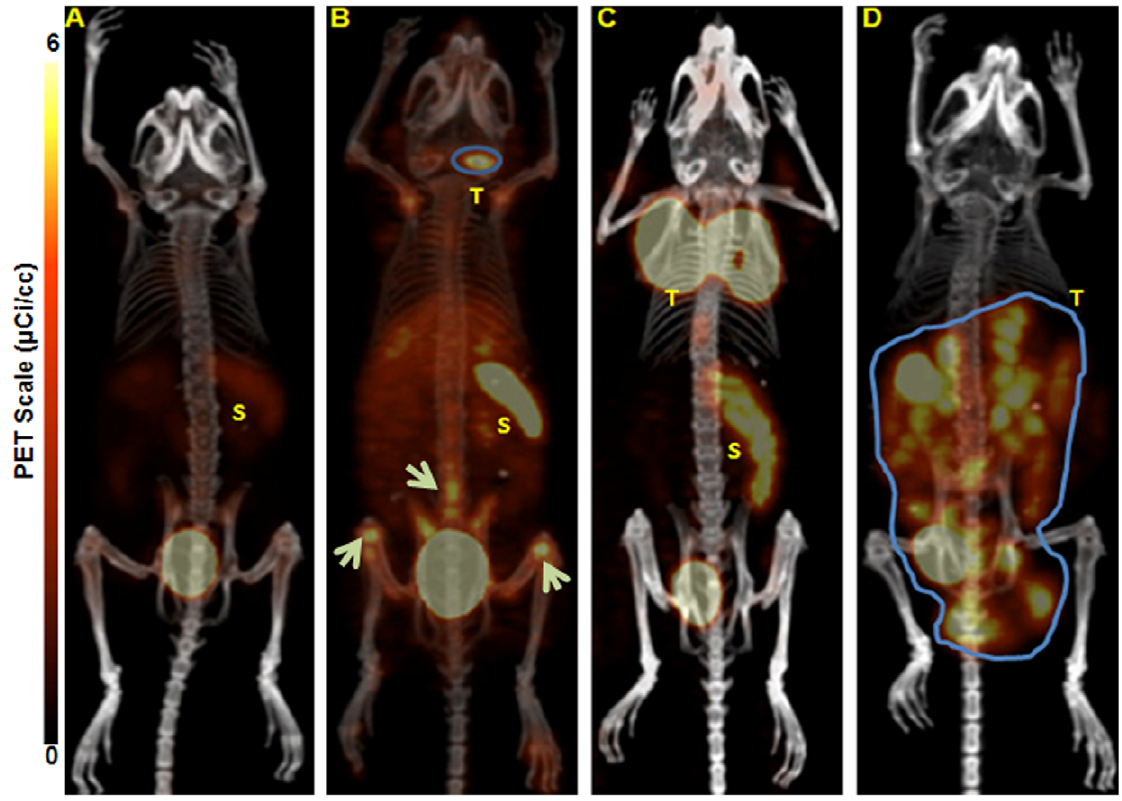
Figure 4. Representative maximum intensity projection (MIP) small animal PET/CT images. A. non-tumor KaLwRij control mouse. B. a small sized, non-palpable, early stage subcutaneous (s.c.) 5TGM1 murine tumor in the nape of the neck inoculated without the use of matrigel (tumor SUV 2.24). White arrows point to suspected tumor cells and associated tumor supporting cells in the BM of the long bones and spine. C. matrigel assisted s.c. 5TGM1 tumor in the nape of the neck (tumor SUV 6.2). D. mouse injected intraperitoneally (i.p.) with 5TGM1 murine myeloma cells. All the mice were injected with 64 Cu-CB-TE1A1P-LLP2A (0.9 MBq, 0.05 m g, 27 pmol) and were imaged by small animal PET/CT at 2 h post-injection. * All tumor bearing animals were SPEP (Serum Protein Electrophoresis) positive. T=Tumor; S=Spleen.